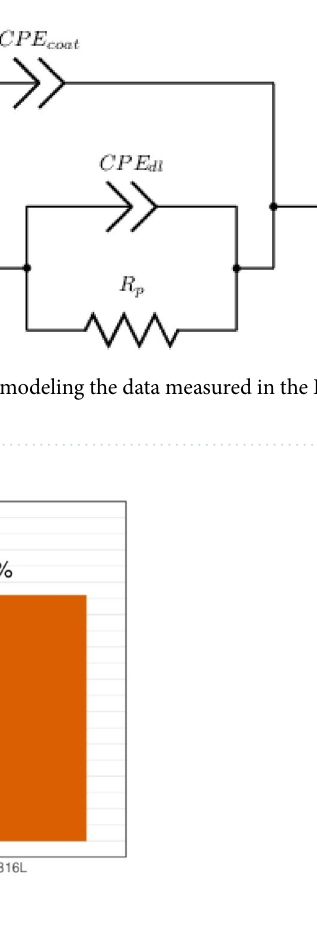
Figure 19. Percentage of cell adhesion of osteoblast on AISI 316L and ZrO 2 -ZrO x N y -316L system. DAPI- stained cells on coated and uncoated stainless steel were counted using fluorescence and percentage was determined with the number of adhered cells divided by total cell number seeded in each